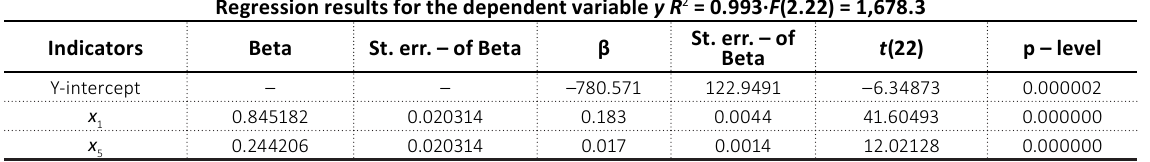
Table 7. Results of the regression